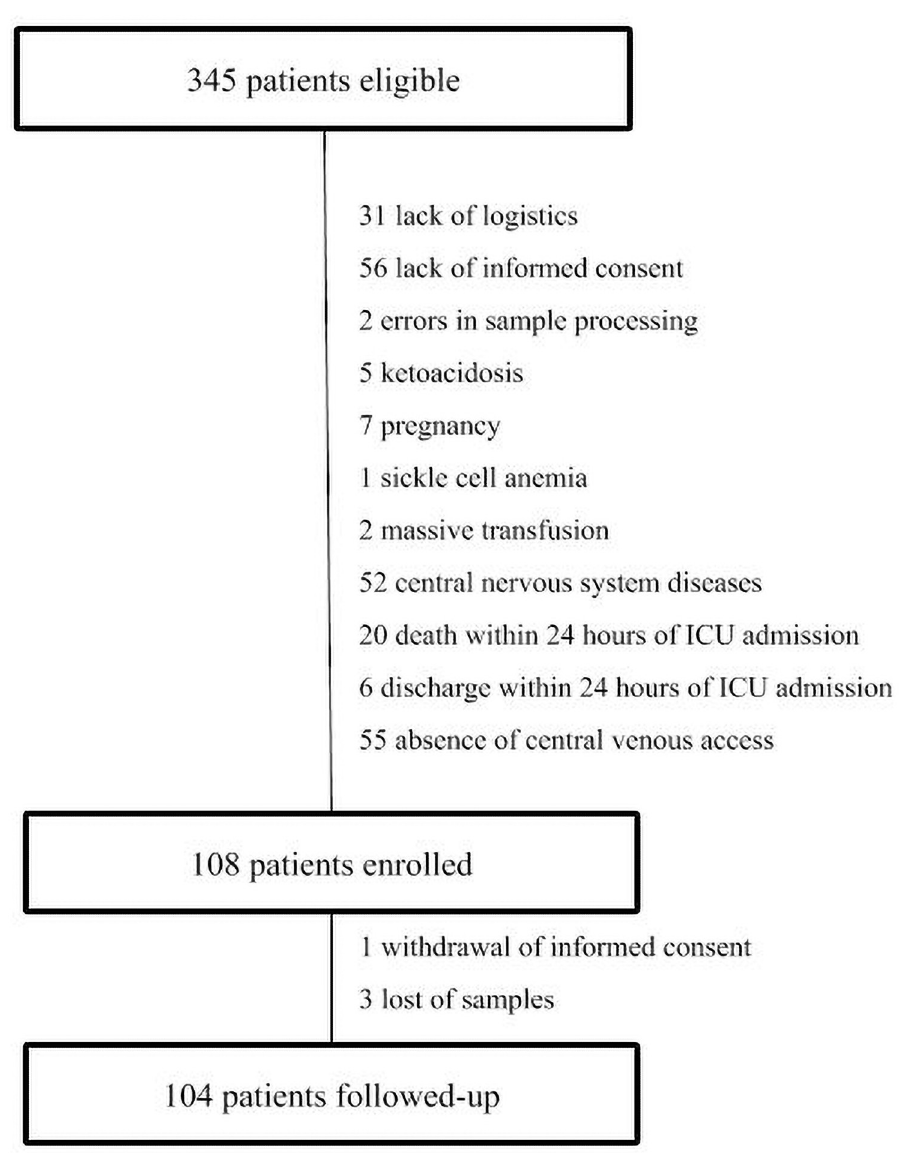
Fig 1. Patient eligibility, enrollment, and follow-up. were men (54.8%), with a mean age of 62 (SD, 15) years and mean SAPS 3 score of 66 (SD, 17). The leading cause of ICU admission was hemodynamic shock (41.3%), followed by acute respiratory failure (31.7%) and postoperative care (16.3%). In addition, there was a high inci- dence of sepsis (68.3%). The most common comorbidities were hypertension (54.8%), diabetes mellitus (33.7%), and heart failure (32.7%). Briefly, 69.2% of patients (n = 72) required mechanical ventilation (MV) and 29.8% (n = 31) required renal replacement therapy (RRT). Overall ICU mortality was 26.9% (n = 28), in-hospital mortality was 37.5% (n = 39) and 90-day mortality was 40.4% (n = 42).